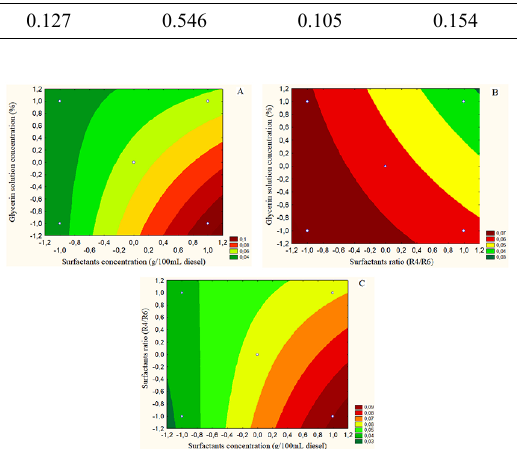
Figure 1. Response surface: (A) concentration of surfactant as a function of the concentration of glycerol solution, (B) proportion between surfactants as a function of the concentration of glycerol solution and (C) concentration of surfactant as a function of the ratio of surfactants.